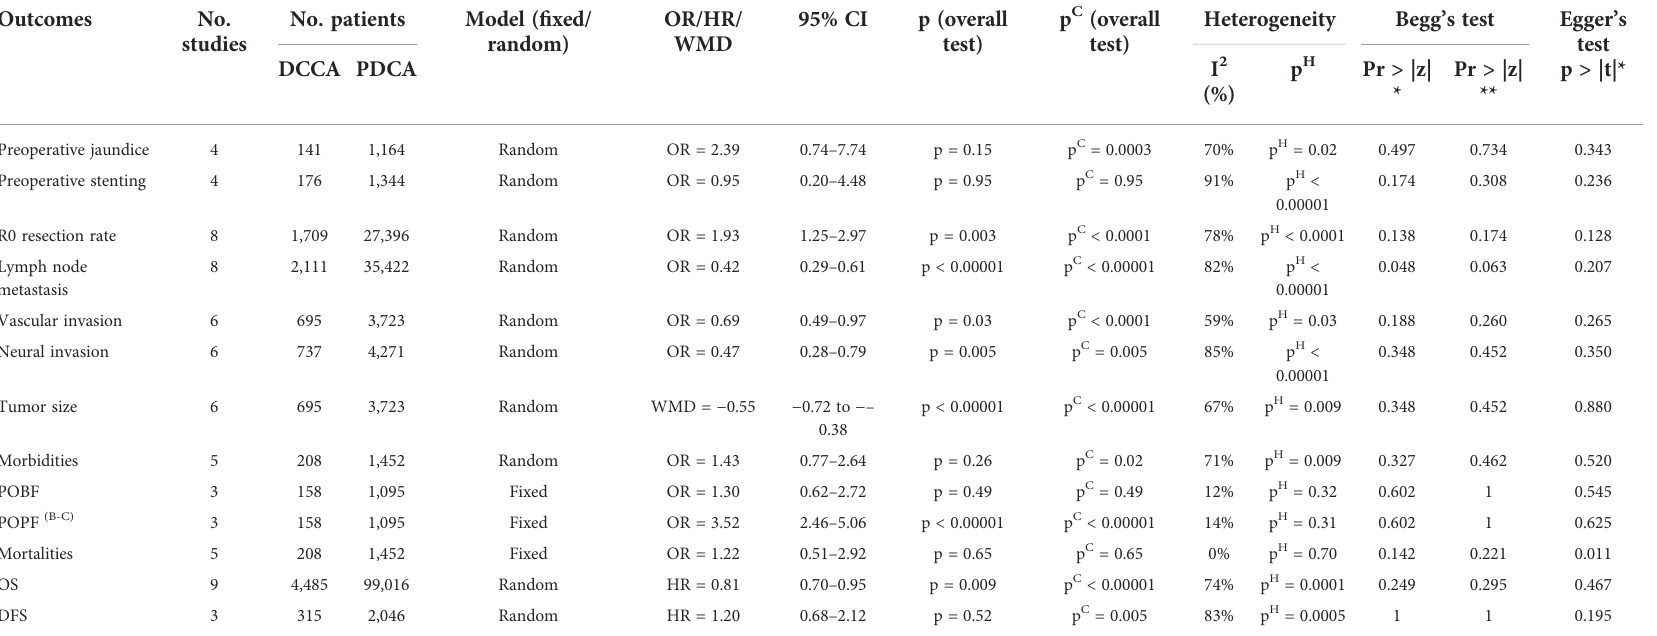
TABLE 2 Pooled results of all available studies in measured